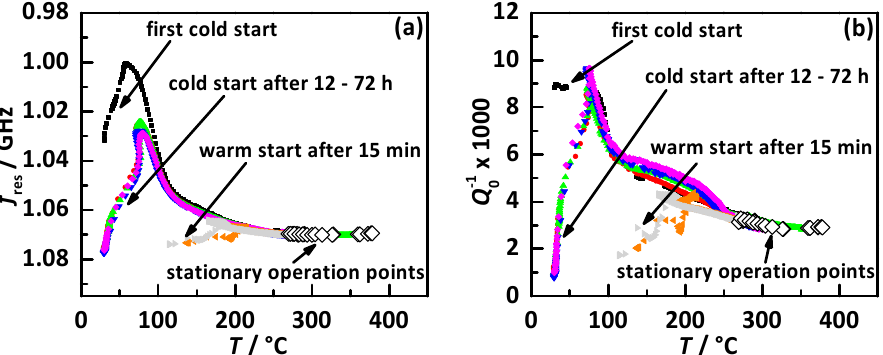
Figure 10. RF signals as a function of catalyst temperature for cold and warm starts under different start conditions (colored symbols) and under stationary conditions (white diamonds from Figure 7) for ( a ) f res and ( b ) Q 0 − 1 .